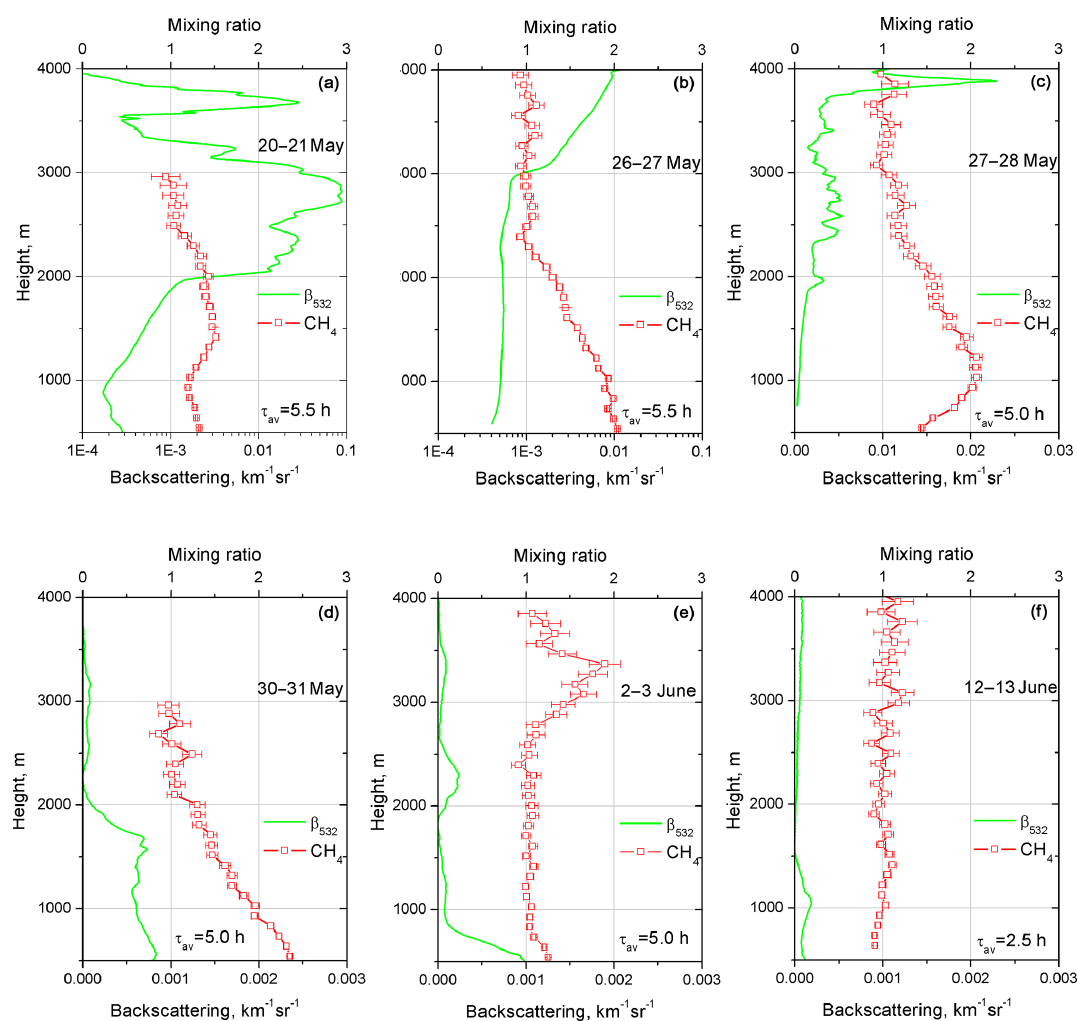
Figure 5. Vertical profiles of the methane mixing ratio and aerosol backscattering at 532nm for six nighttime measurement sessions: (a) 20– 21 May, (b) 26–27 May, (c) 27–28 May, (d) 30–31 May, (e) 2–3 June and (f) 12–13 June 2018. Mixing ratios are not calibrated and the value 1.0 corresponds to approximately 2ppm. Signal-averaging time τ av is given in